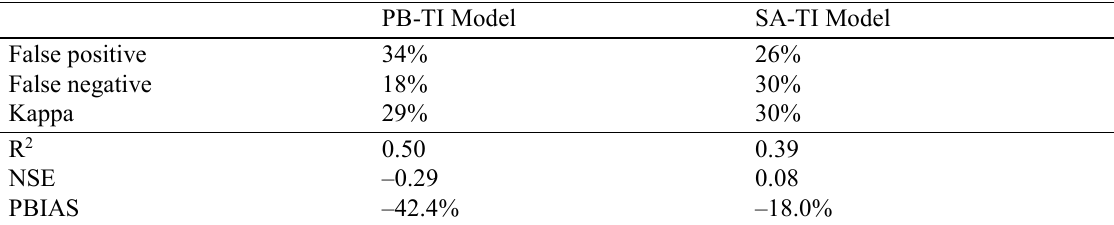
Table 1 EG occurrence (rows one to three) and length (rows four to six) statistics for observed, PB-TI and SA-TI models.